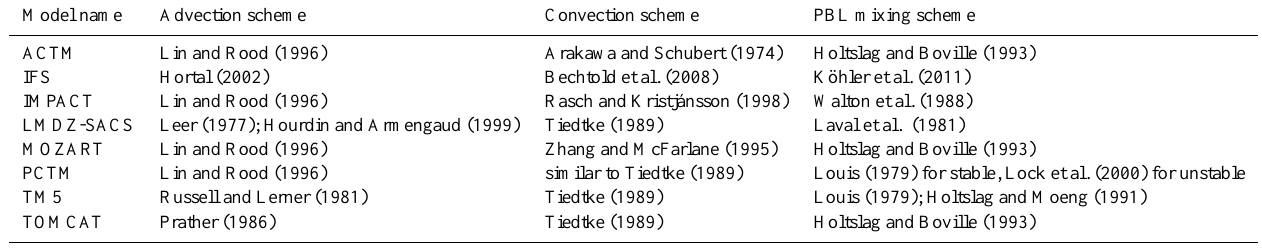
Table 2. Main transport and sub-grid parameterization schemes (advection, convection and planetary boundary layer (PBL) schemes) of the TransCom models used in this experiment.